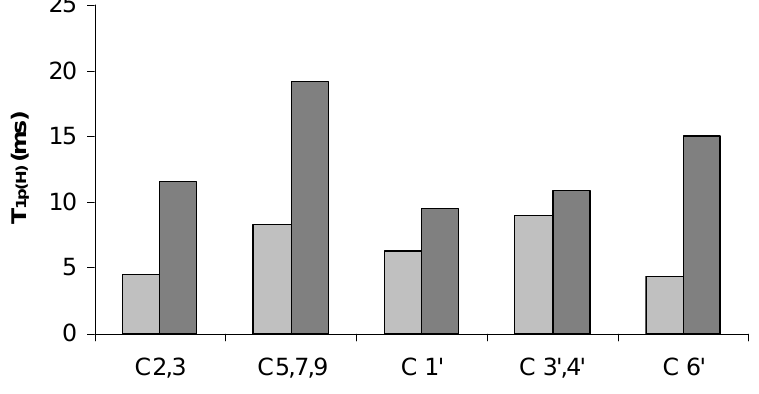
Figure 5. A comparison of the spin relaxation T and tannin propionate using NMR spin locking experiments. ■ Tannin and ■ tannin propionate.